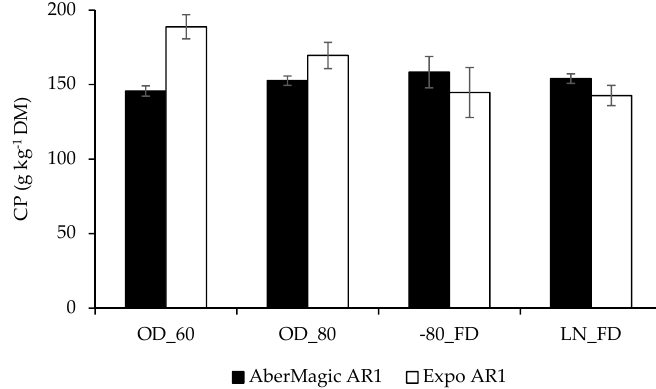
Figure 3. Crude protein (CP) concentration as affected by cultivar and drying procedure on the third sampling (June 2017; winter). OD_60: oven-drying at 60 °C for 48 h, OD_80: oven-drying at 80 °C for 16 h, − 80_FD: freezing at − 80 °C for 48 h followed freeze-drying, LN_FD: liquid nitrogen followed freeze-drying. Vertical bars represent the standard error of the mean.